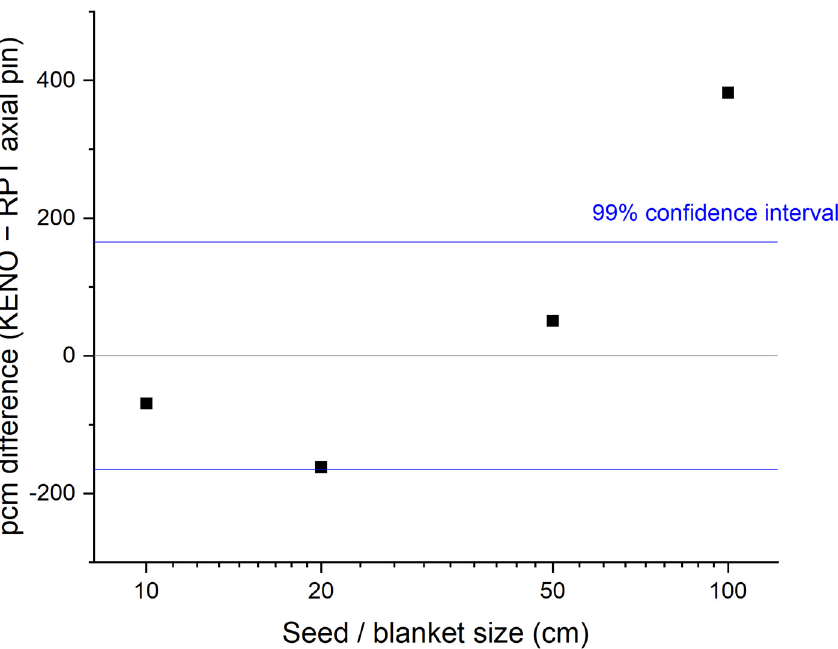
Figure 17. Difference in pcm units between the k-eff values of the 3D SCALE KENO and an equivalent axial pin model modified by the given fuel width modification factor. In this case, a seed and blanket geometry of 50 cm regions and a void fraction of 50% is used to calibrate the RPT. The results show that, firstly and most importantly, axial heterogeneity can be successfully modelled by the RPT method in 2D, and that the method requires recalibration for different axial geometries to be well-validated.